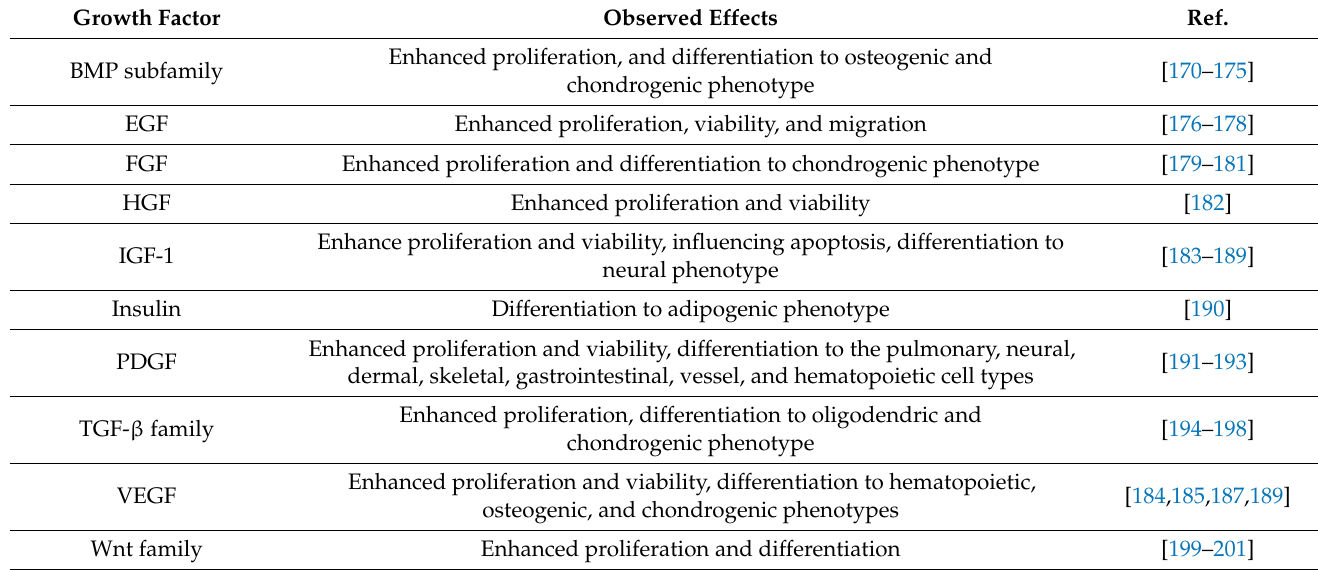
Table 6. Effects of various growth factors on stem cell